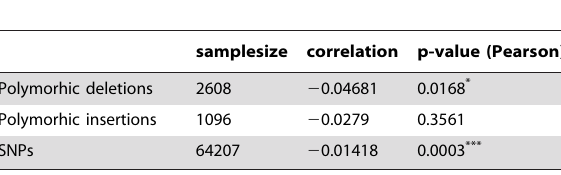
Table 6. Linear model of the log-transformed recombination rate.